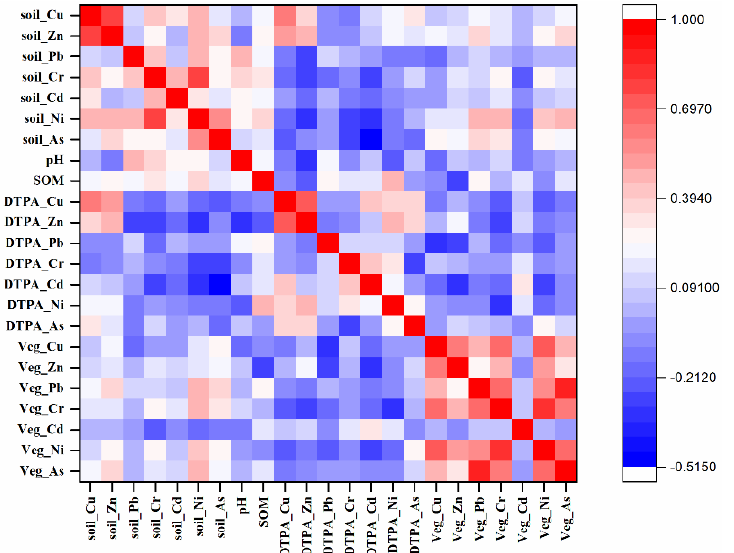
Figure 8. Pearson correlation matrix of HMs in soils (mg kg − 1 ), soil DTPA-extractable metal content (mg kg − 1 ), and metal accumulation in vegetable samples (mg kg − 1 ).